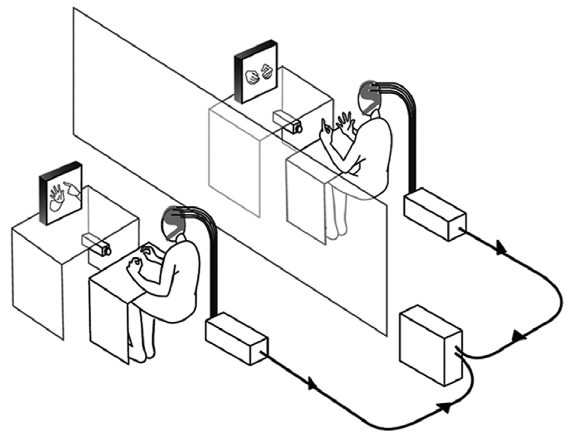
Figure 2. An imitation task, as described by [34].